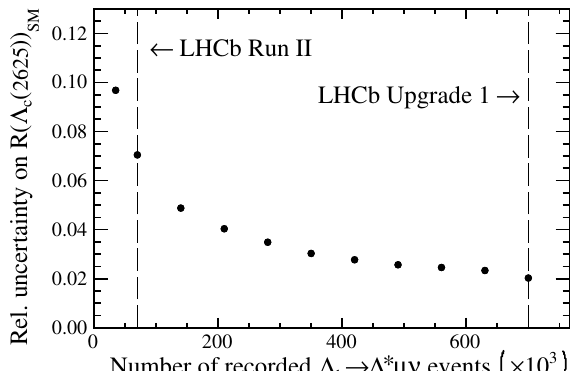
Figure 4 . Expected theoretical precision of the R (cid:3) 0 ! (cid:3) (cid:3) + (cid:22)(cid:23) events recorded by the LHCb experiment. The yields expected at the end of the LHC c b Run II and after the LHCb upgrade 1 are highlighted by the vertical